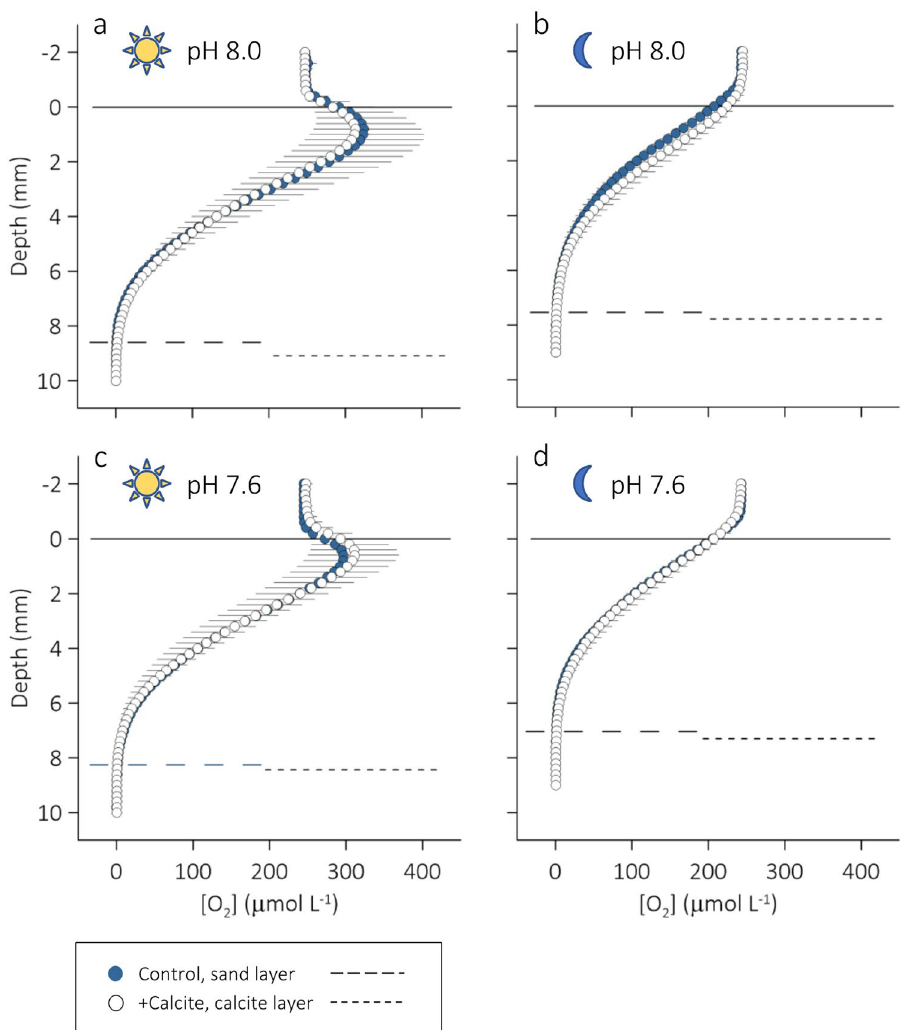
Figure 3. Average (n = 6) vertical microprofiles of porewater [O 2 ] measured in intact cores of subtidal silt submerged in ( a , b ) ambient seawater and ( c , d ) CO 2 -enriched seawater under conditions of ( a , c ) light and ( b , d ) darkness. A 1 mm surface layer of either sterile sand (blue symbols, Control) or calcite (open symbols, +Calcite) was added to the sediment cores at the start of the experiment. The horizontal lines at 0 mm depth indicate the position of the sediment surface. Black horizontal lines extending to the right or left of the symbols indicate 1 SD. The dashed horizontal line indicates the average O 2 penetration depth in Control (long dash) and +Calcite (short